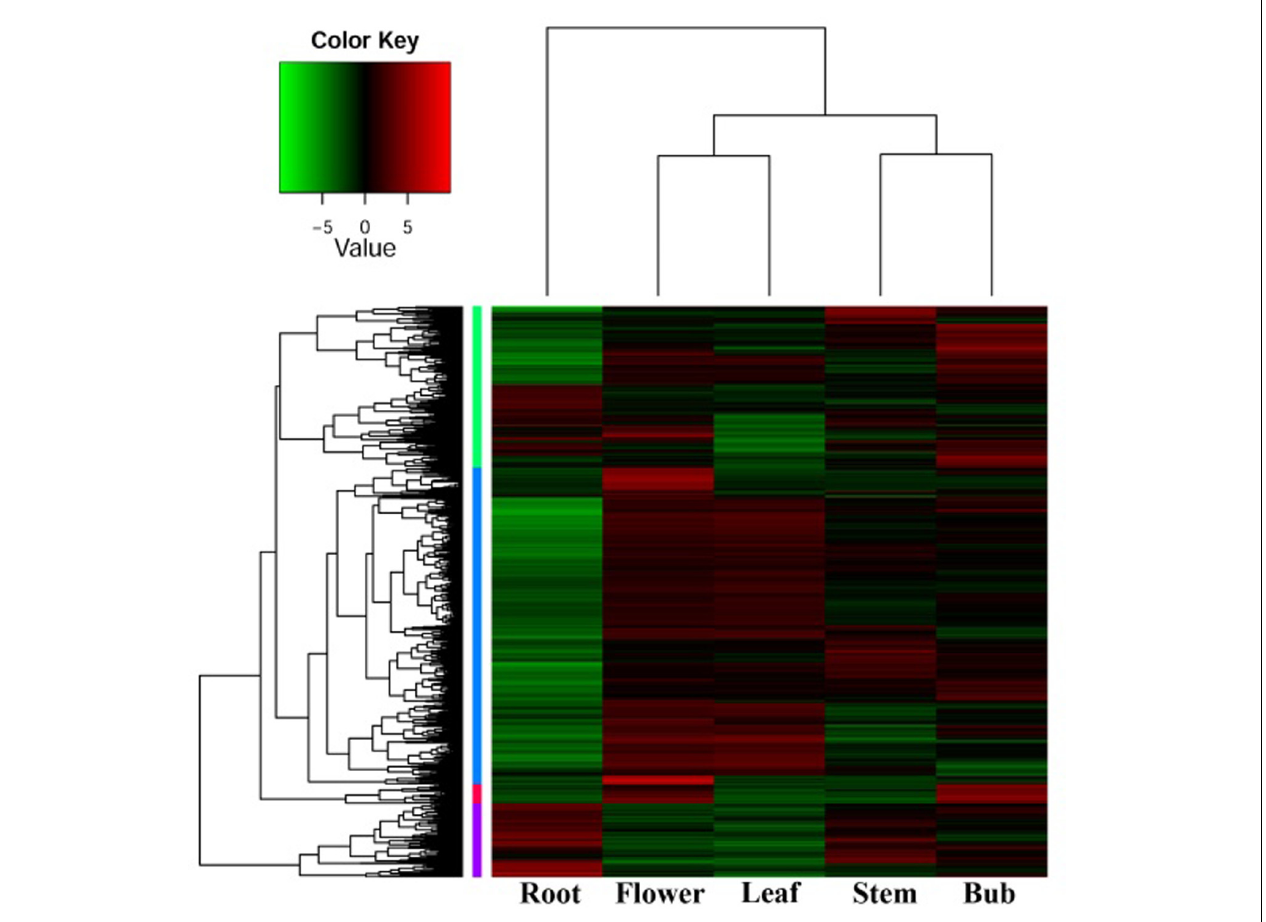
FIGURE 1 | A differential expression heatmap showing the expression of genes from different D. nipponica